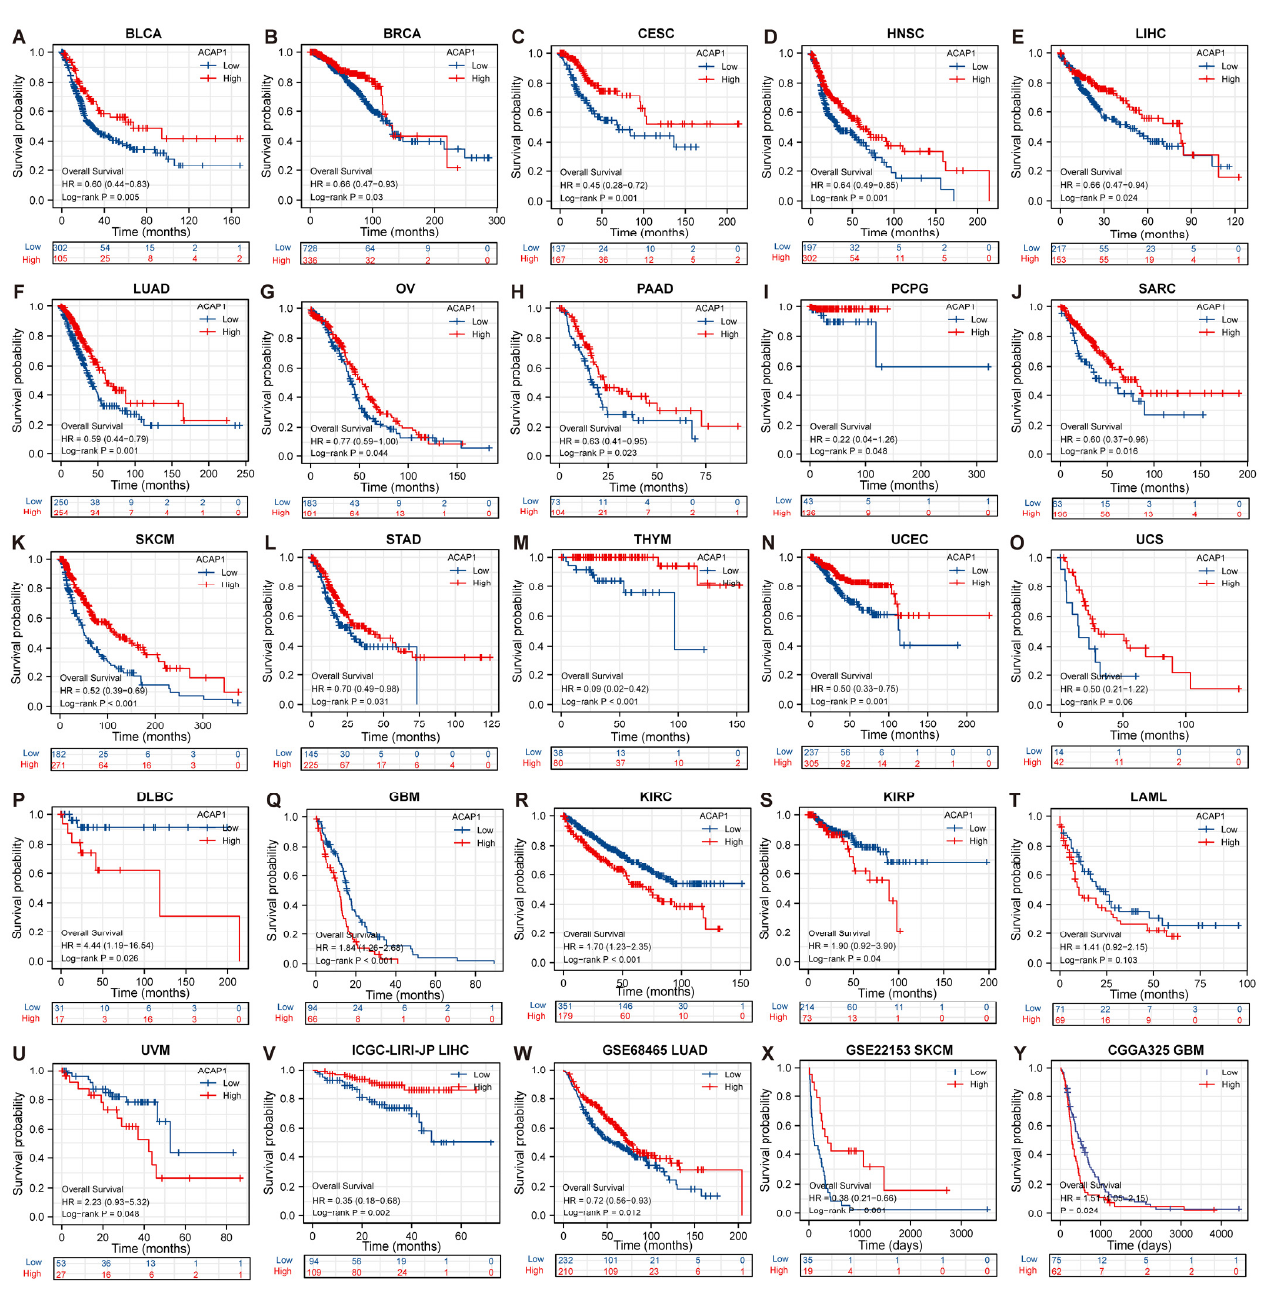
Figure 4. Implications of ACAP1 expression on overall survival of cancer patients across multiple cancer types. ( A – U ) Overall survival analyses of cancer patients stratified by ACAP1 mRNA level with the Kaplan–Meier method in TCGA datasets. ( V – Y ) Overall survival analyses of cancer patients stratified by ACAP1 mRNA level in ICGC-LIRI-JP(LIHC), GSE68465(LUAD), GSE22153(SKCM), and CGGA325(GBM) datasets.